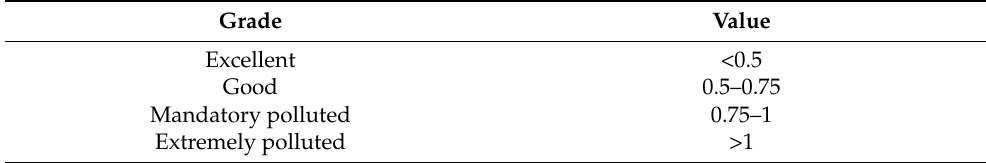
Table 3. The score of the WPI to justify the water pollution level [32].